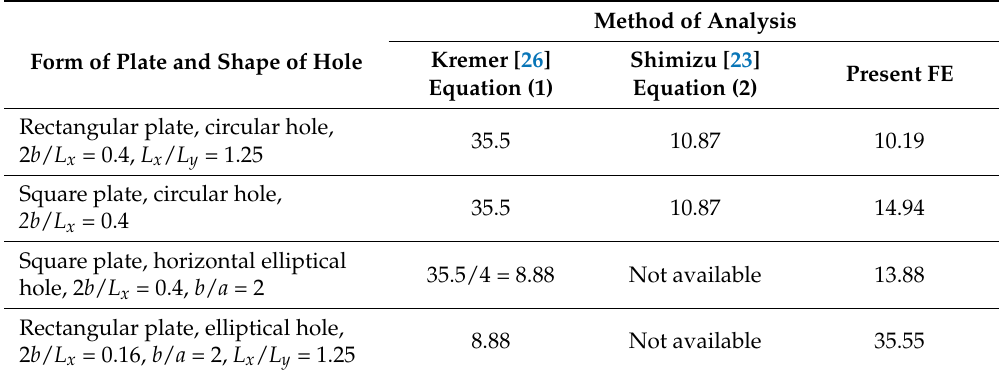
Table 1. Analytical estimations of buckling loads versus finite element computations.